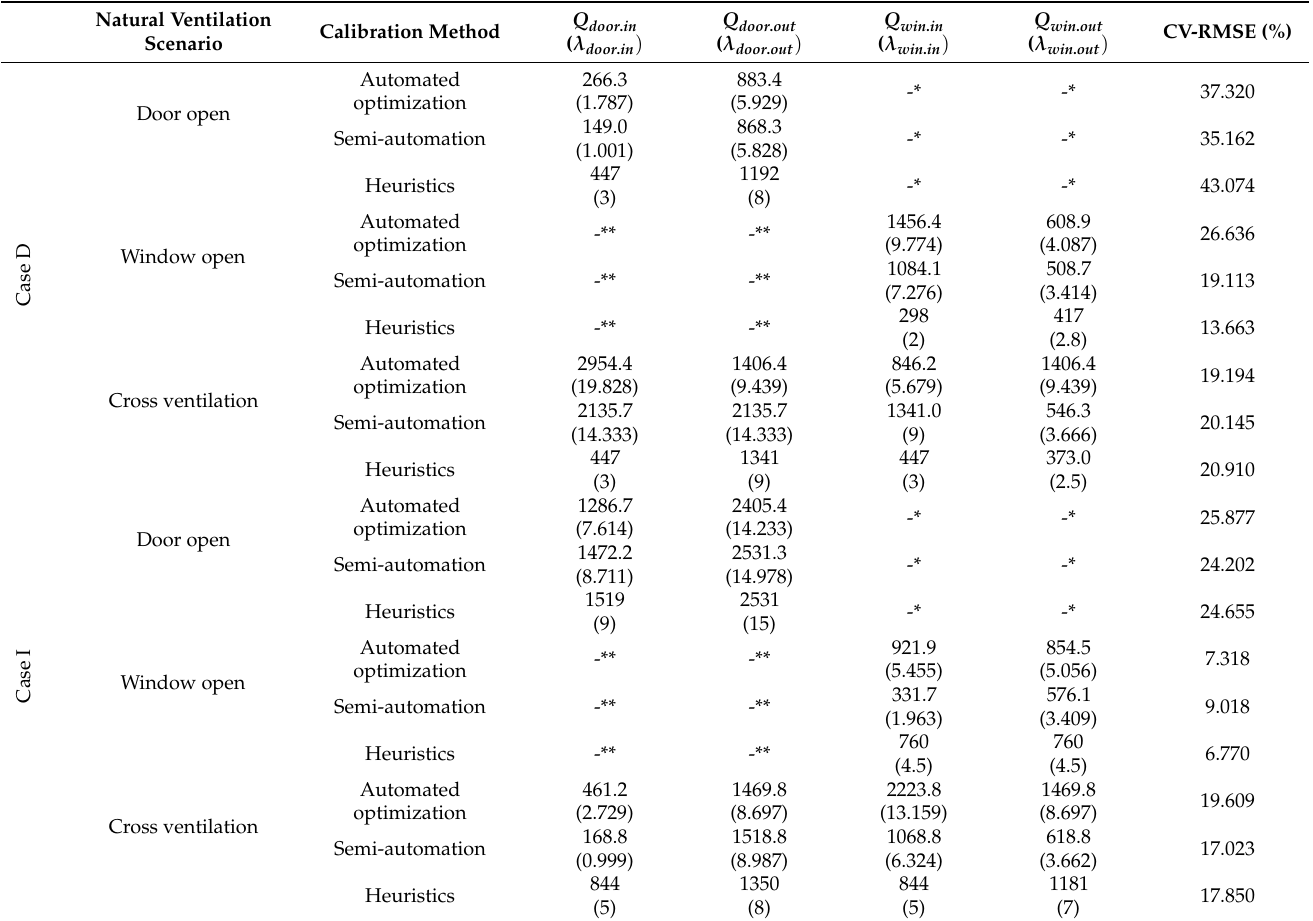
Table 4. Estimated values of the control variables for natural ventilation